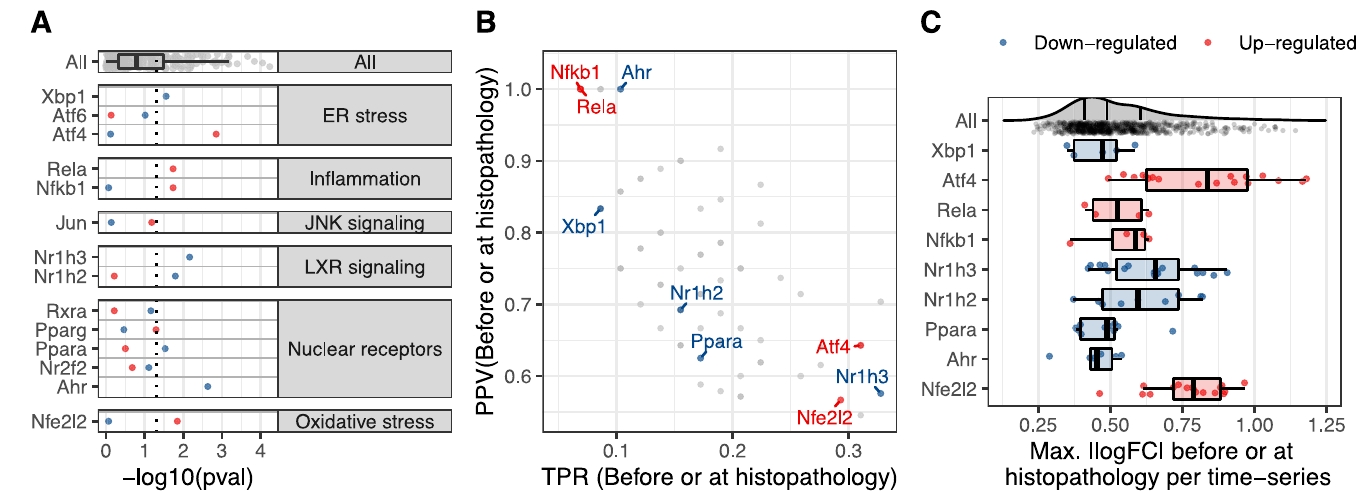
Fig 7. Temporal concordance of nuclear receptors and adaptive response transcription factors (TFs) in DILI. For known TFs in DILI the following time concordance metrics are shown: A) The enrichment significance before or at first adverse histopathology, B) Positive Predictive Value (PPV) and True Positive Rate (TPR), C) Max. mean |logFC| before or at first adverse histopathology. As background distribution in grey, the statistics for all inferred TFs is shown.